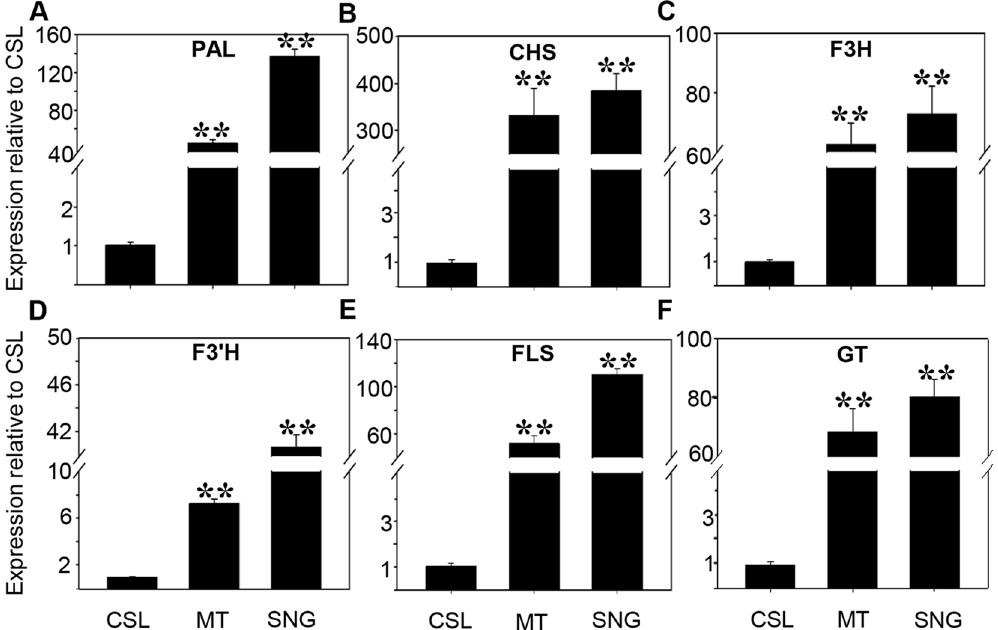
Figure 3. Analysis of transcript levels of the main genes in flavonol metabolism in three cherry tomato cultivars by qRT-PCR. Analyzed genes are described in Fig. 1. ( A ) PAL, phenylalanine ammonialyase; ( B ) CHS, chalcone synthase; ( C ) F3H, flavanone-3-hydroxylase; ( D ) F3 ′ H, flavonoid-3 ′ -hydroxylase; ( E ) FLS, flavonol synthase; ( F ) GT, flavonol-3-glucosyltransferase. Two or three fruits were pooled from each plant. Each value was normalized to the gene expression in cultivar CSL and is indicated as the mean ± standard deviation of three experimental replicates. ** P <